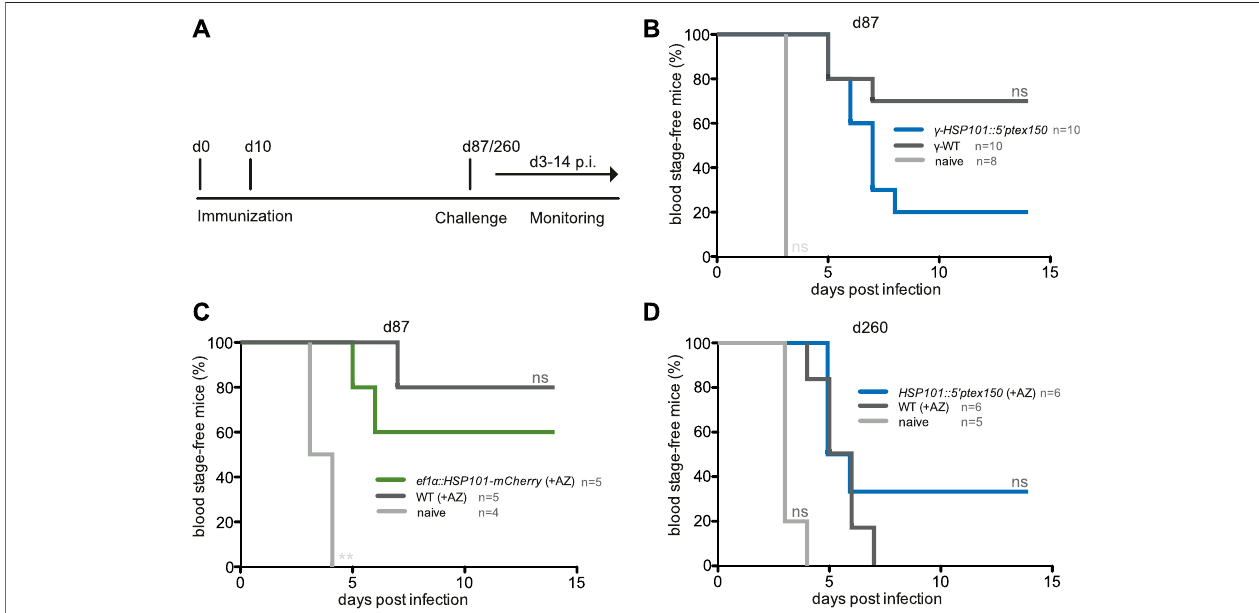
FIGURE 5 | Inferior protection in mice vaccinated with attenuated ef1 α :HSP101-mCherry or HSP101:5 ′ ptex150 sporozoites. (A) Overview of immunization and challenge protocol. C57bl/6 mice were immunized twice at a 10-days interval with 10,000 intravenously injected (i.v.) sporozoites. Challenge infections with 10,000 i. v. WT sporozoites was done at indicated time points. Monitoring of blood infection was done daily by microscopic examination of Giemsa-stained blood fi lms. (B – D) Kaplan-Meieranalysisofbloodinfectionovertimeafterintravenoussporozoiteinjection. (B) Immunizationswithirradiated HSP101:5 ′ ptex150 (blue)andWT(black) sporozoites. (C) Immunizations with azithromycin-arrested ef1 α :HSP101-mCherry (green) and WT (black) sporozoites. (B,C) Challenge infections were done on day 87 (77daysaftertheboosterimmunization). (D) Immunizationswithazithromycin-arrested HSP101:5 ′ ptex150 (blue)andWT(black)sporozoites.Challengeinfectionswere done on day 260(250 days after the booster immunization). Naivemice (grey) served as infection controls in all experiments. n. s, non-signi fi cant (Log rank (Mantel-Cox)